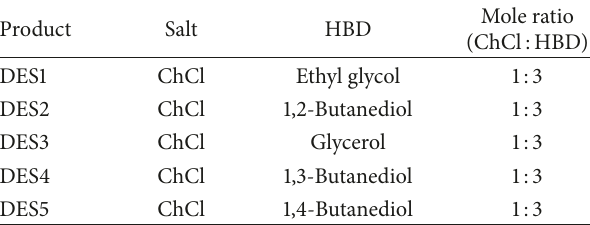
Table 1: DESs synthesized in the work.